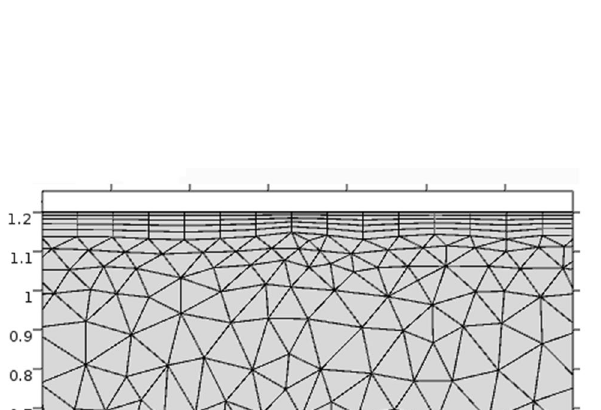
Table 1 Meshes for different simulated geometries